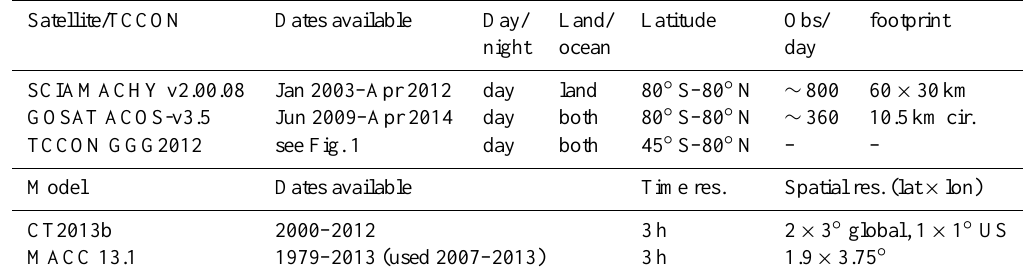
Table 1. Summary of the CO 2 data sets and models we used, showing the coverage for several different CO 2 products. The obs/day are the approximate number of CO 2 observations which passed quality